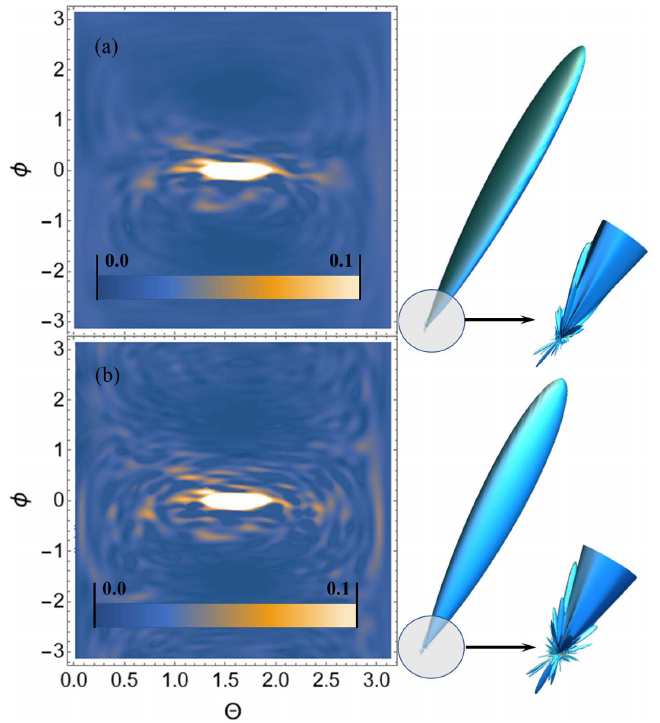
Figure 6. USP scattering spectra on the CUG trinucleotide: ( a ) calculated using Equation (4), ( b ) cal- culated by Equation (1). The spectra are presented as 2D ( left ) and 3D ( right ) plots. The 2D plots are presented in dimensionless units and normalised to the maximum value of the spectrum. The angles φ , θ are spherical angles in the coordinate system shown in Figure 2.